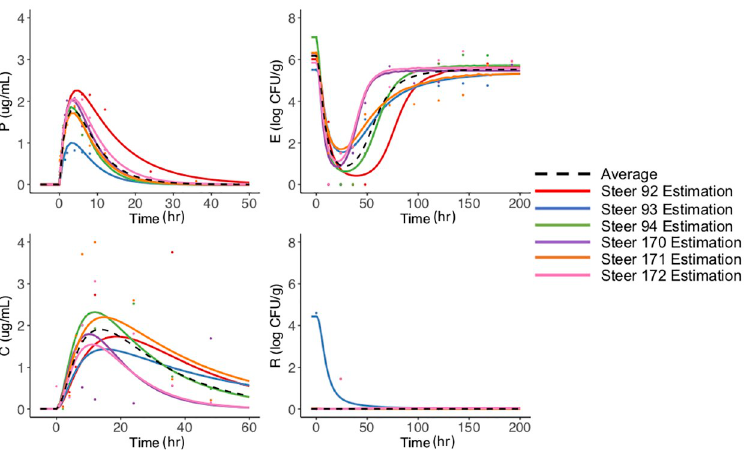
Fig 2. High dose steer dynamics. Prediction of the high dose treatment group. Estimation of the concentration of antimicrobial drugs in the plasma, P , colon, C and estimation of the amount of the total E. coli and E. coli above the ECOFF in the feces. Each steer is represented by the same color for model predictions (lines) and corresponding data (dots). The median population estimate for each compartment is the black dashed line.